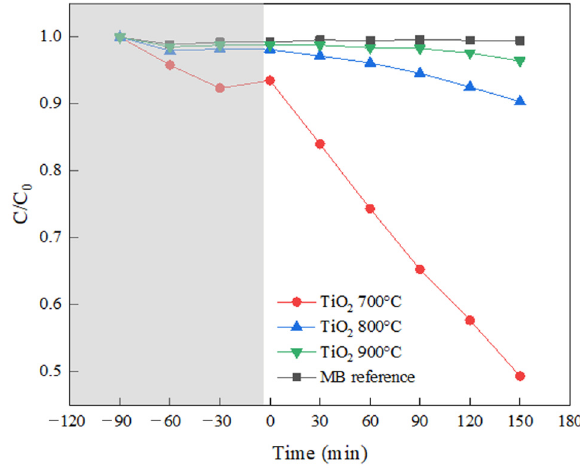
Figure 3. Methylene Blue photo-degradation on TiO 2 powders annealed at several temperatures. The experiments were conducted three times with an error below 1%.